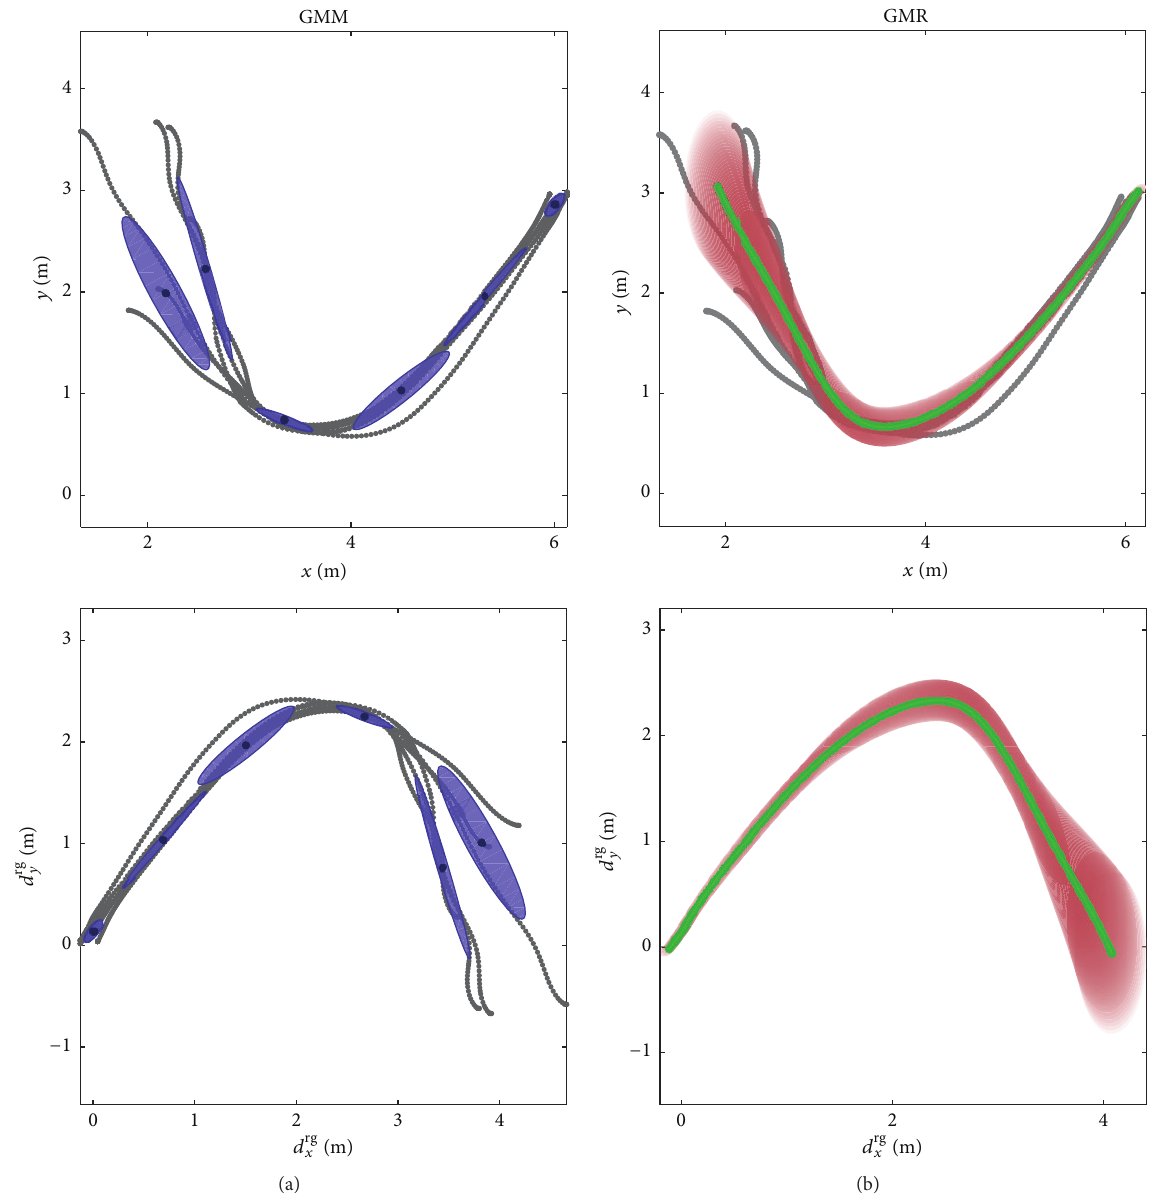
Figure 7: Trajectory encoding and retrieval using GMM and GMR for task 1. (a) represents model encoding with GMM. Ellipse in dark blue represents projections of Gaussian components. (b) represents general trajectory generated by GMR. Shades in red color represent generation